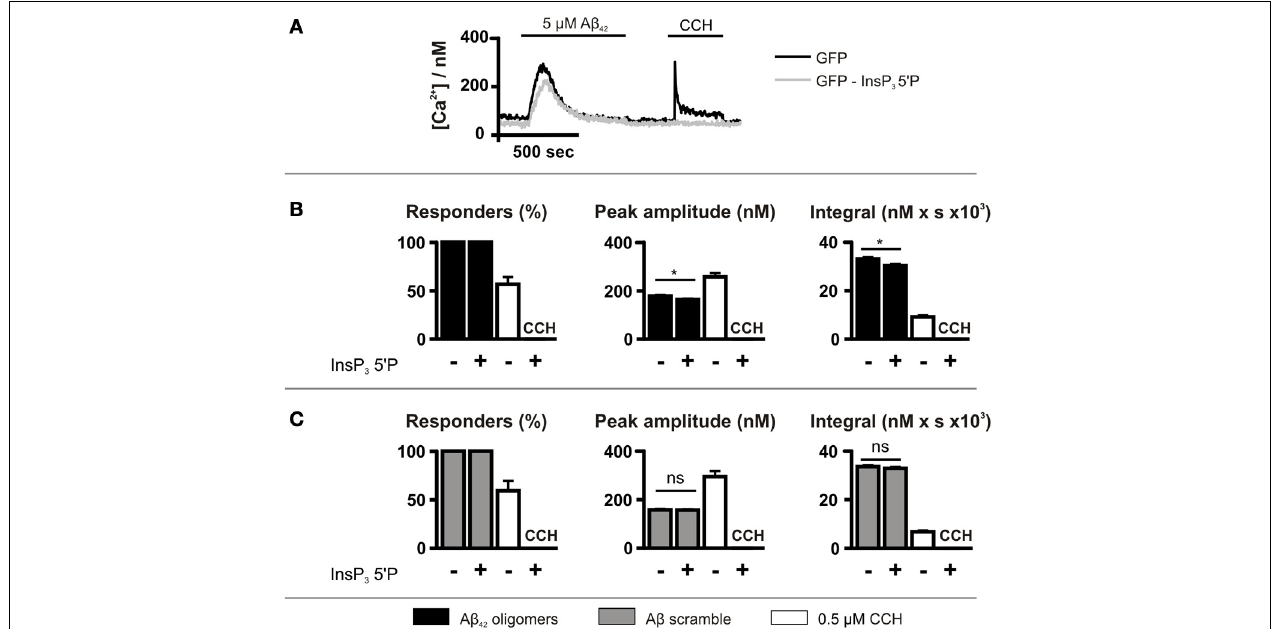
FIGURE 5 | A β 42 oligomer-induced Ca 2 + release occurs is reduced by InsP 3 5 (cid:2) P expression. (A) Imaging protocol employed to investigate the involvement of InsP 3 Rs in A β 42 oligomer-mediated Ca 2 + release from the ER. InsP 3 was metabolized by overexpression of InsP 3 5 (cid:3) P. (B,C) Bar charts illustrating the magnitude of Ca 2 + responses elicited by SH-SY5Y cells